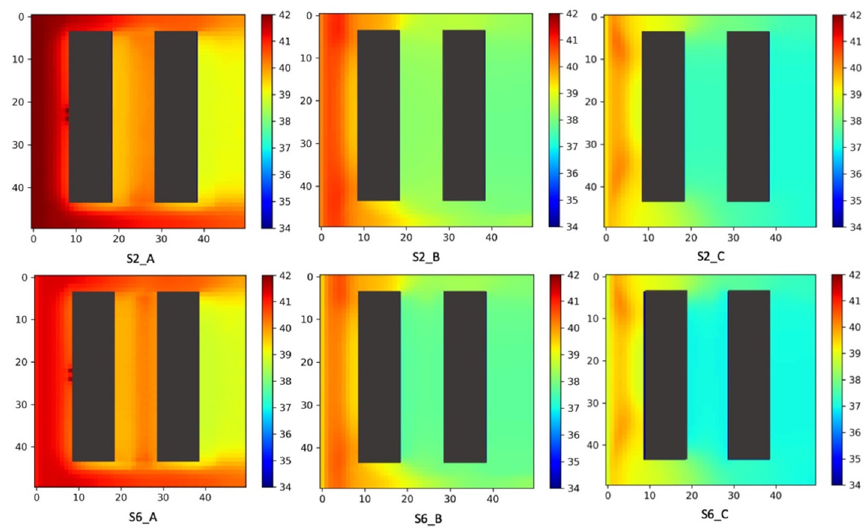
Figure 10. Near-surface temperature (°C) distribution of scenarios with different green types and densities in shallow (A), deep (B), and very deep (C) canyons at 15:00.